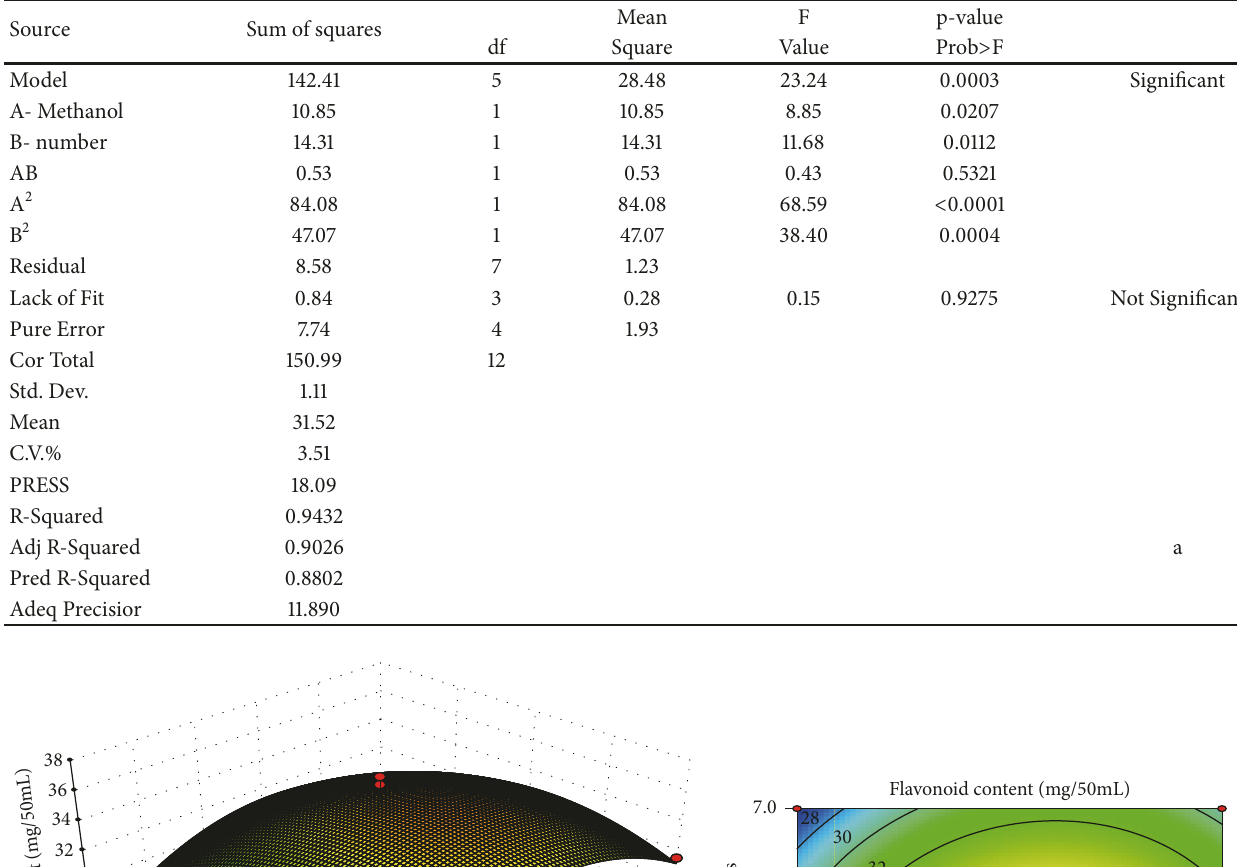
Table 6: ANOVA and R-squared for the selected factorial model.